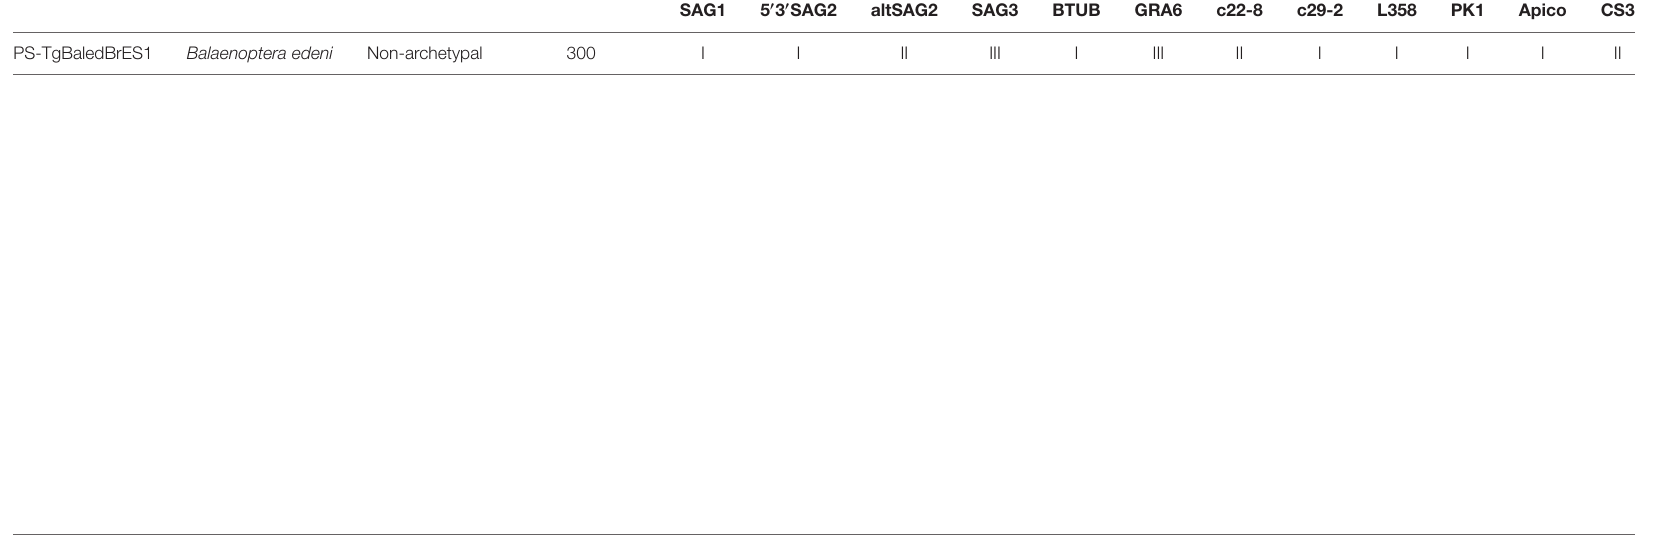
TABLE 2 | Genotyping results of Toxoplasma gondii with 15 microsatellite markers from a Bryde’s whale ( Balaenoptera edeni ) stranded in Pontal do Ipiranga, Linhares, Espirito Santo state (Brazil).